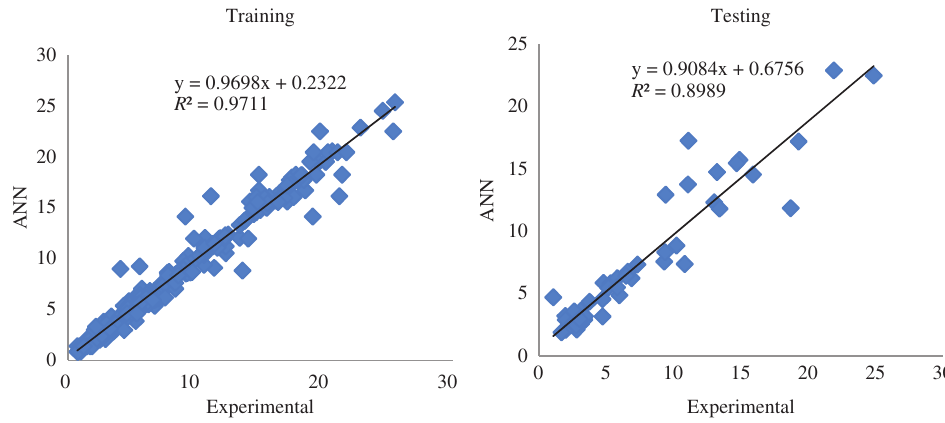
Figure 14: Scatter plot of predicted and experimental values of bond strength of proposed ANN